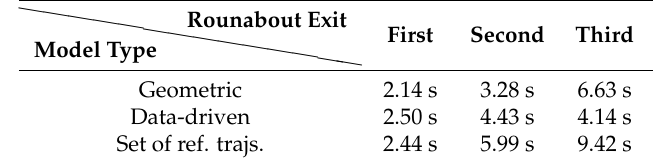
Table 1. Mean time (larger is better) from convergence to the correct exit direction until exiting from the roundabout.